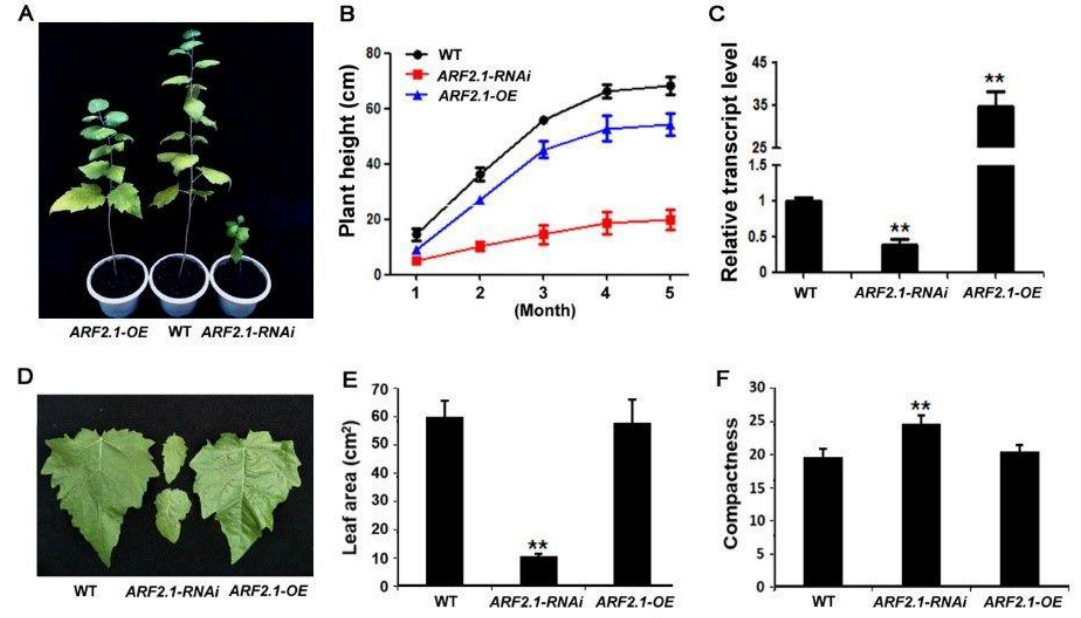
Figure 3. Phenotype analysis of PtrARF2.1 overexpressed and suppressed poplars. ( A ) Representative five-month-old PtrARF2.1 -OEand PtrARF2.1-RNAi plants compared with the wildtype (WT). ( B ) Comparison of plant height in WT, PtrARF2.1 -OEand PtrARF2.1-RNAi plants. Measurements were made for 30 plants of each line during five months of plant growth in the greenhouse. Error bars mean ±SD value for each line. ( C ) Quantitative RT-PCR analysis of PtrARF2.1 transcripts in representative PtrARF2.1-RNAi and PtrARF2.1 -OE lines. The poplar 18S rRNA was used as an internal control. Error bars mean ±SD of three biological replicates. ( D ) Representative 5-month-old leaf phenotypes from PtrARF2.1-RNAi and PtrARF2.1 -OE lines in comparison with the WT control. ( E ) Comparison of the leaf area in PtrARF2.1-RNAi , PtrARF2.1 -OE and WT plants. Error bars mean ±SD of three biological replicates. (F) Quantitative analysis of the leaf index value of compactness from PtrARF2.1-RNAi , PtrARF2.1 -OE and WT plants. Error bars mean ±SD of three biological replicates. Stars indicate the statistical significance using Student’s t -test: ** p -value <